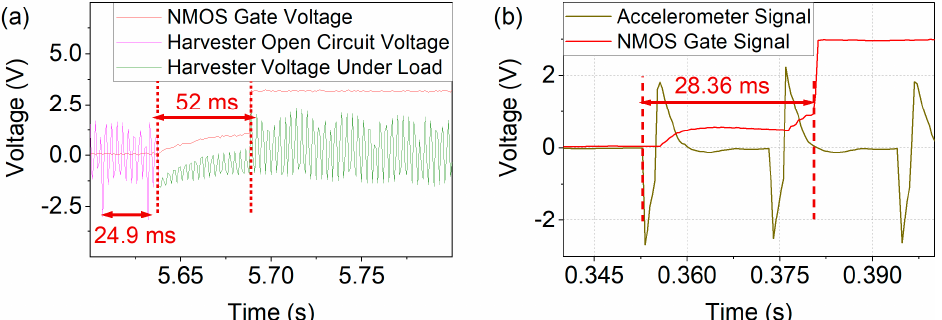
Figure 10. Time resolved wakeup process corresponding to the dashed intervals in Figure 9. ( a ) Voltage output of the harvester in magnetic excitation (f exc = 40 Hz). Upon connection to the circuit the capacitors are charged accompanied by a drop in output voltage due the load. ( b ) Mechanical excitation in which the necessary gate voltage is reached after two acceleration pulses at f exc = 48.14 Hz and a exc = 22 g.